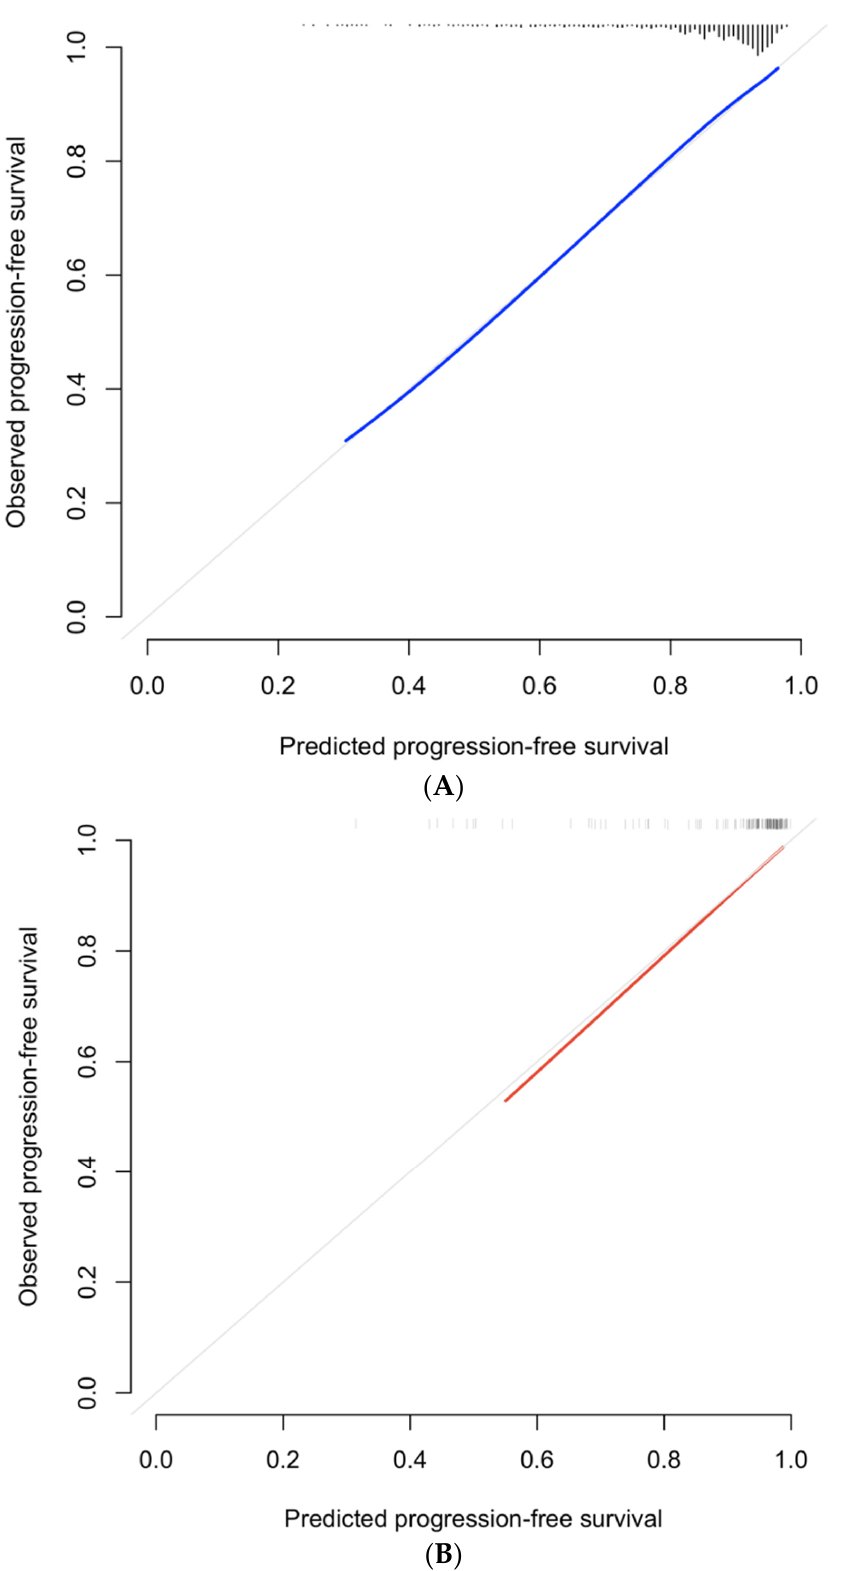
Figure 3. Calibration curves at 4 years for internal validation ( A ), and external validation ( B ).